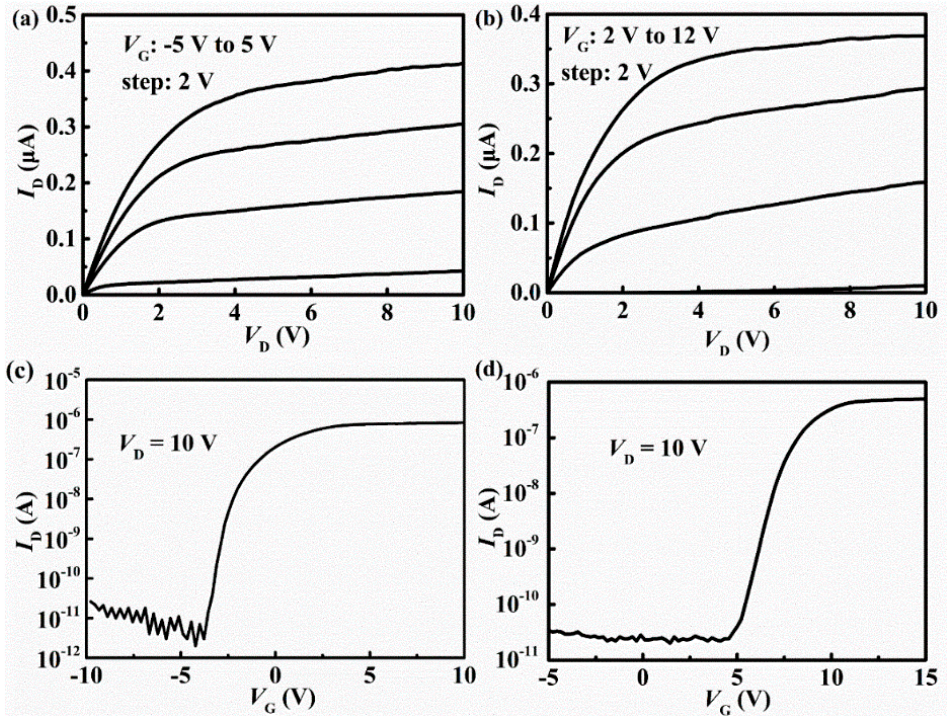
Figure 5. ( a ) Output characteristic curve with various V G before and after ( b ) etching of β − Ga 2 O 3 FET, the transfer curve in log scale before ( c ) and after ( d ) etching.